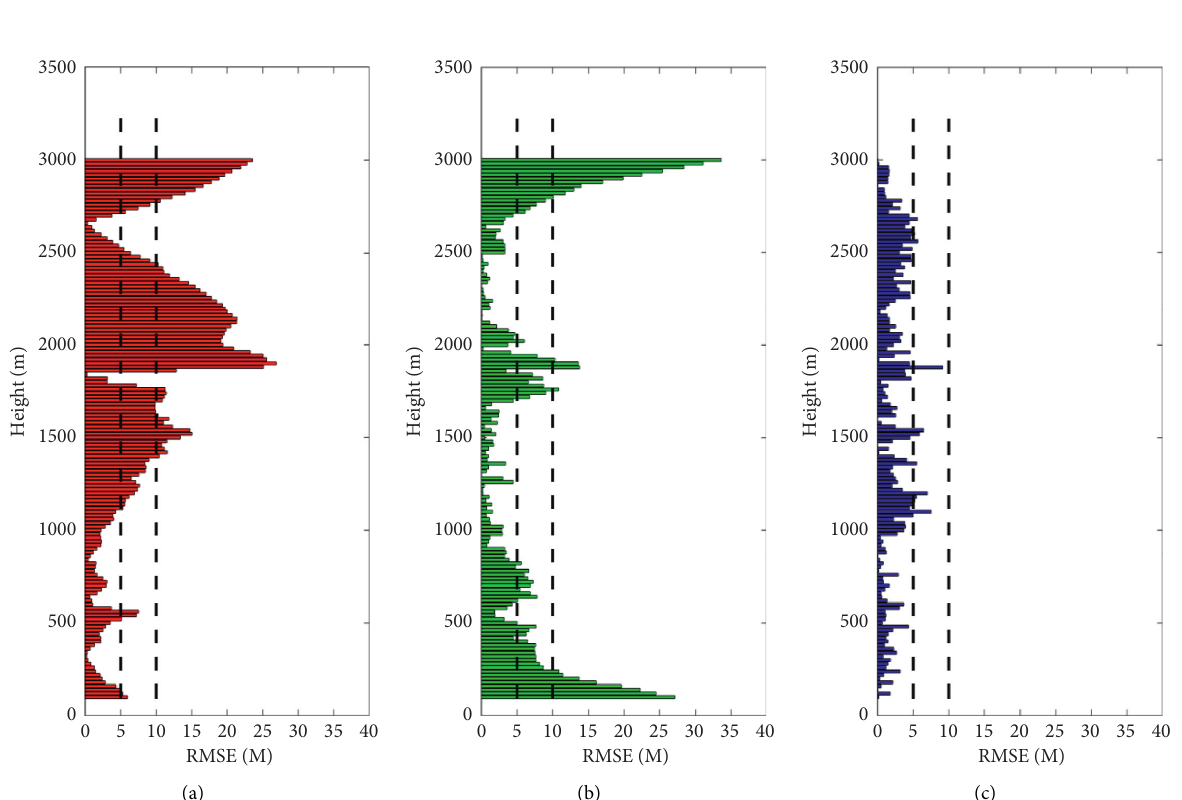
Figure 7: The MAPE of the selected